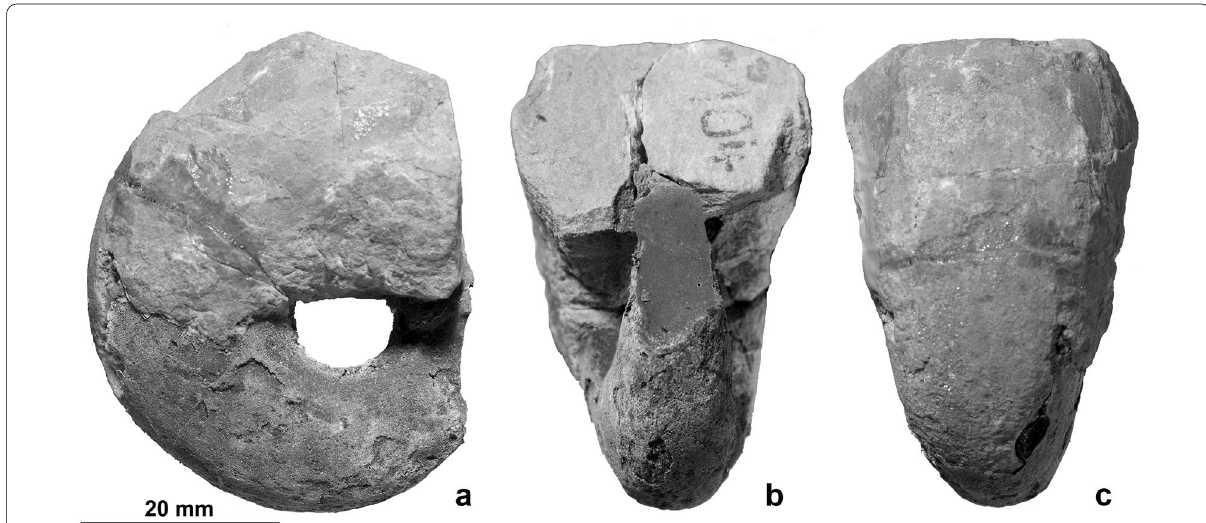
Fig. 5 Syringonautilus sp., PIMUZ 37903, P. 902/Mirigioli (Monte San Giorgio), Middle Besano Formation (bed 104), uppermost Anisian: a lateral view, left side, b oral view, c ventral